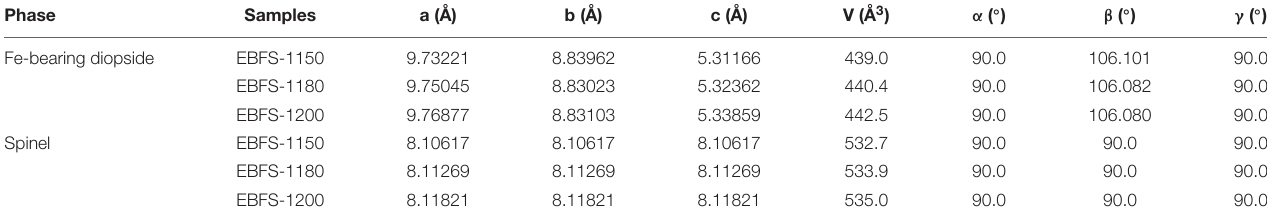
TABLE 3 | Cell parameters and volumes of Fe-bearing diopside and spinel. Phase